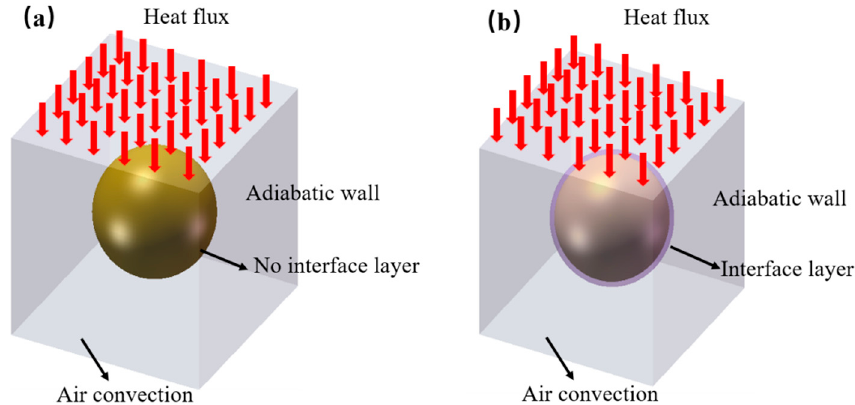
Figure 4. The model of finite element simulation for a thermally conductive unit: ( a ) model without interface layer; ( b ) model with interface layer.